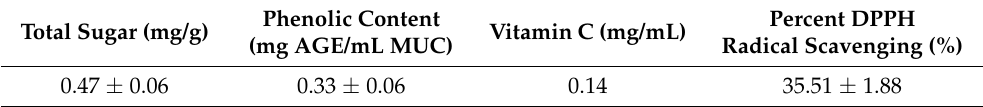
Table 2. Composition of ethanol extracted cactus